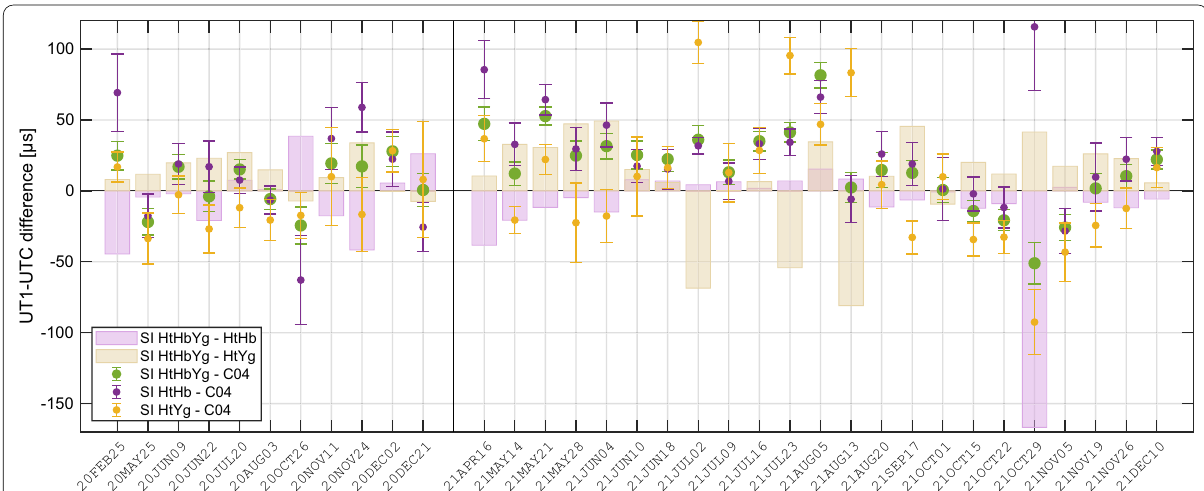
Fig. 9 Comparison of UT1 UTC derived from the SI full network HtHbYg and the SI single baselines HtHb and HtYg and with respect to C04 in − units of µs. Dots with error bars illustrate the differences to C04, with the error bars reflecting the UT1 series: HtHbYg (green), HtHb (purple), HtYg (yellow). Purple and yellow bars show the UT1 and the single baseline solutions HtHb and